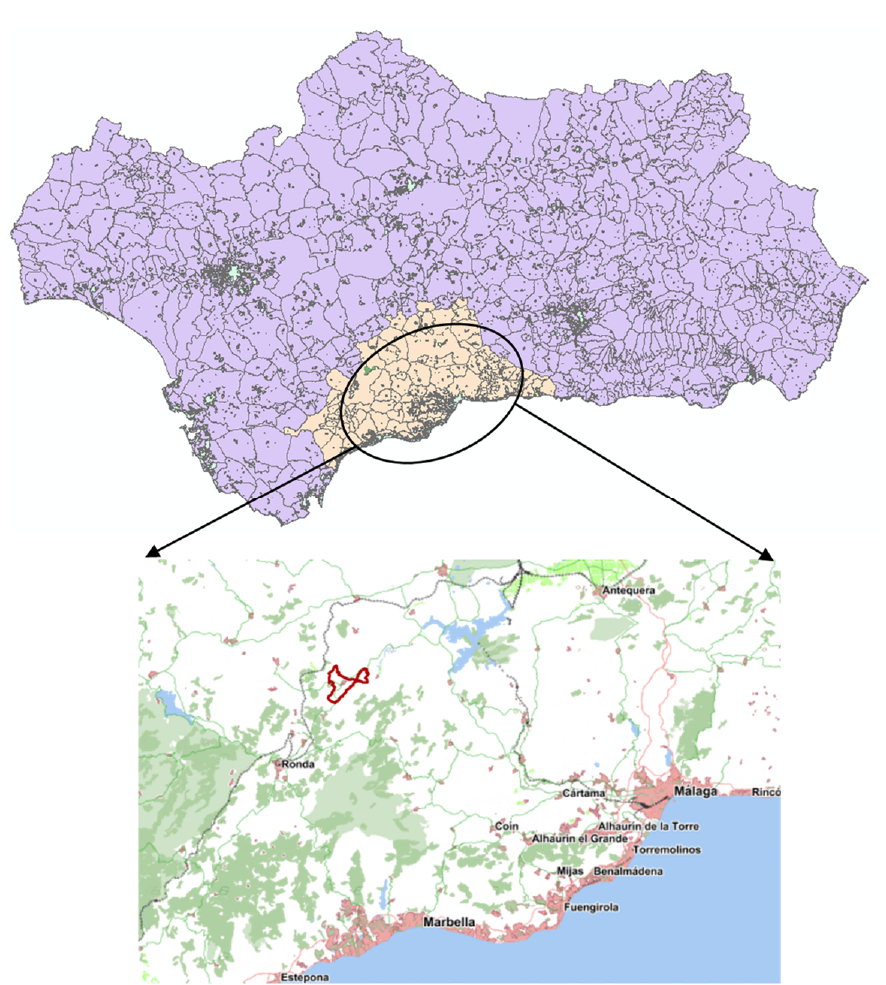
Figure 1. Map of Andalusian region (purple colour) Málaga providence (yellow colour) and Cuevas del Becerro municipality (red